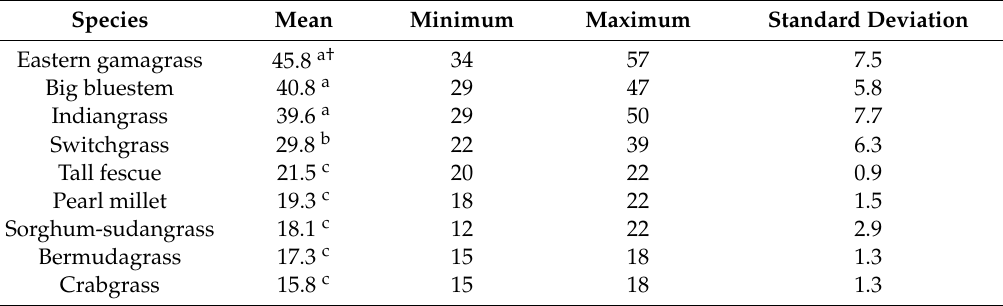
Table 3. Least square means for length of survival (days post-watering) by species in greenhouse experiment, University of Tennessee, Knoxville, TN,